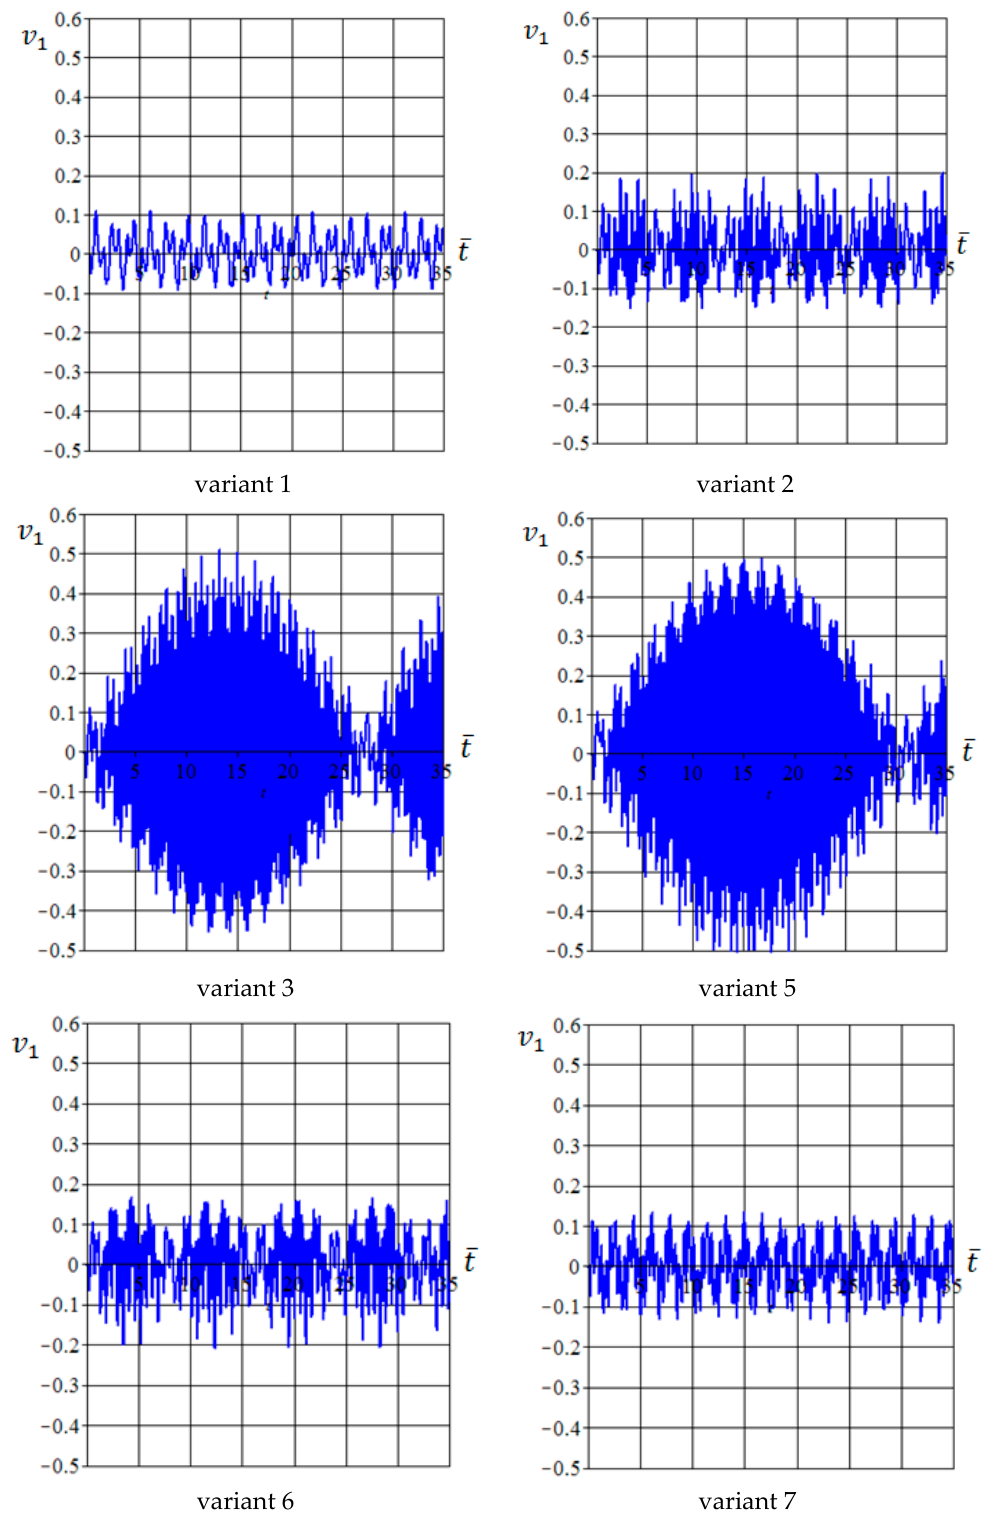
Figure 14. Forced free end tail boom oscillations v 1 ( 0, L ) (in mm) at different γ values (variant